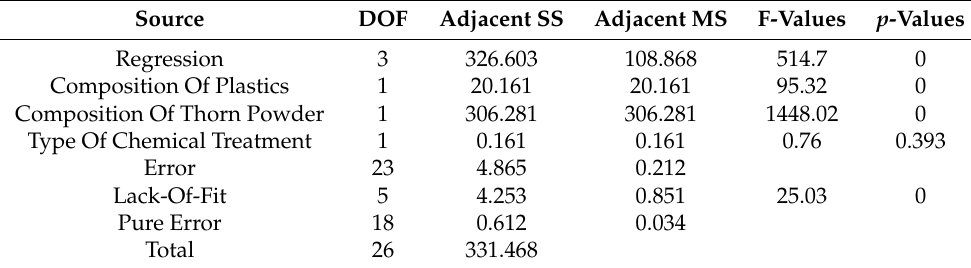
Figure 4. Contribution plot for Maximum Hardness. Table 3. Hardness